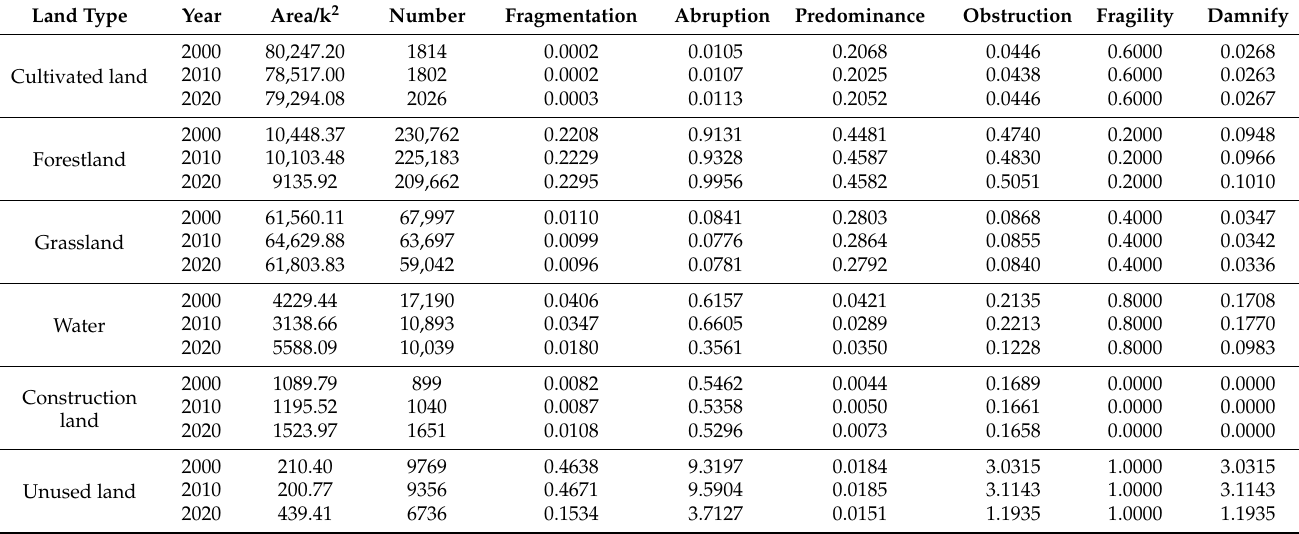
Table A2. Landscape pattern index of Akmola State from 2000 to 2020.